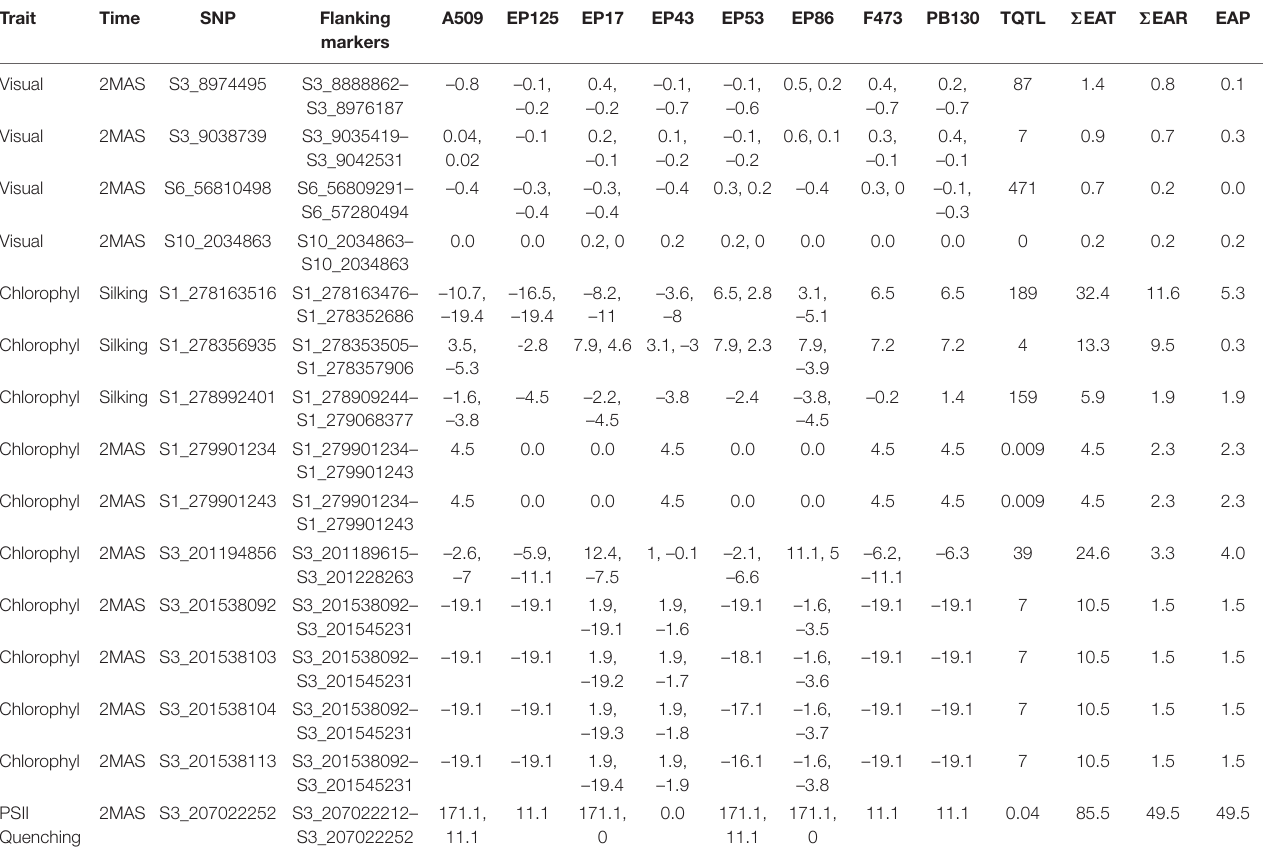
TABLE 3 | QTLs mapped with significant SNPs associated across traits and evaluation time point.